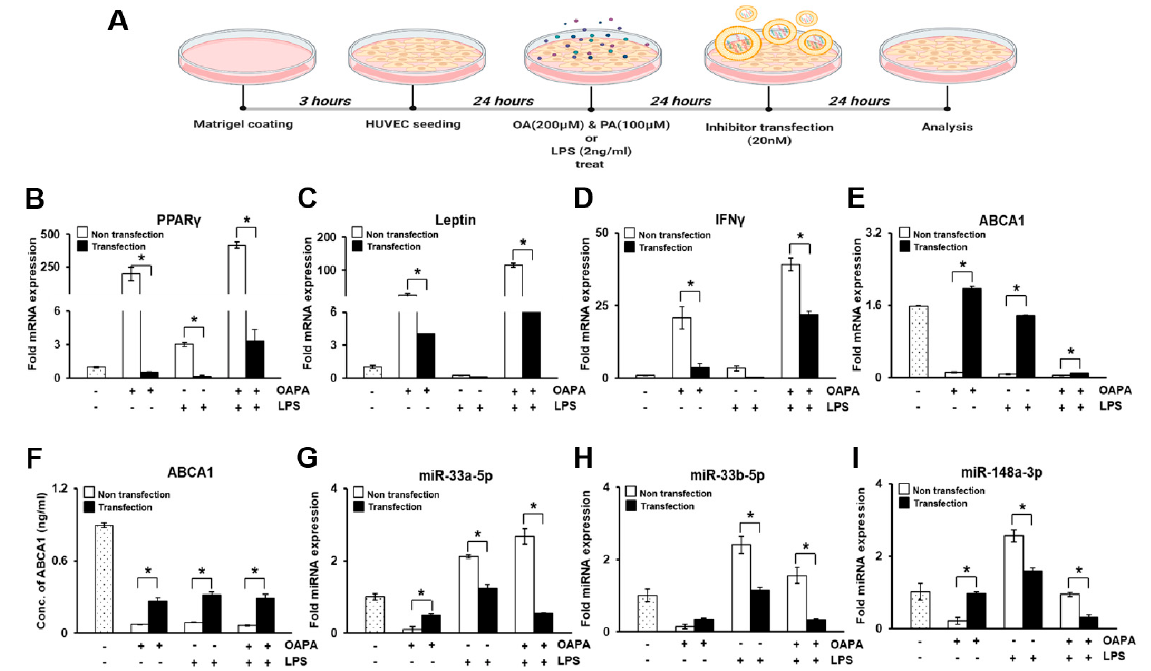
Figure 8. In vitro study in HUVECs. ( A ) Experimental scheme of in vitro experiment using HUVECs. mRNA expression of PPAR γ ( B ), leptin ( C ), IFN- γ ( D ), and ABCA1 ( E ) by qRT-PCR. ( F ) Expression of soluble ABCA1 in culture supernatant by ELISA. miRNA expression of miR-33a-5p ( G ), miR-33b-5p ( H ), and miR-148a-3p ( I ) by qRT-PCR. Mean ± SD ( n = 3 per group); * p < 0.05; t -test. OAPA, oleic acid, and palmitic acid; LPS, lipopolysaccharide; -, non-treated group; +, treated group.